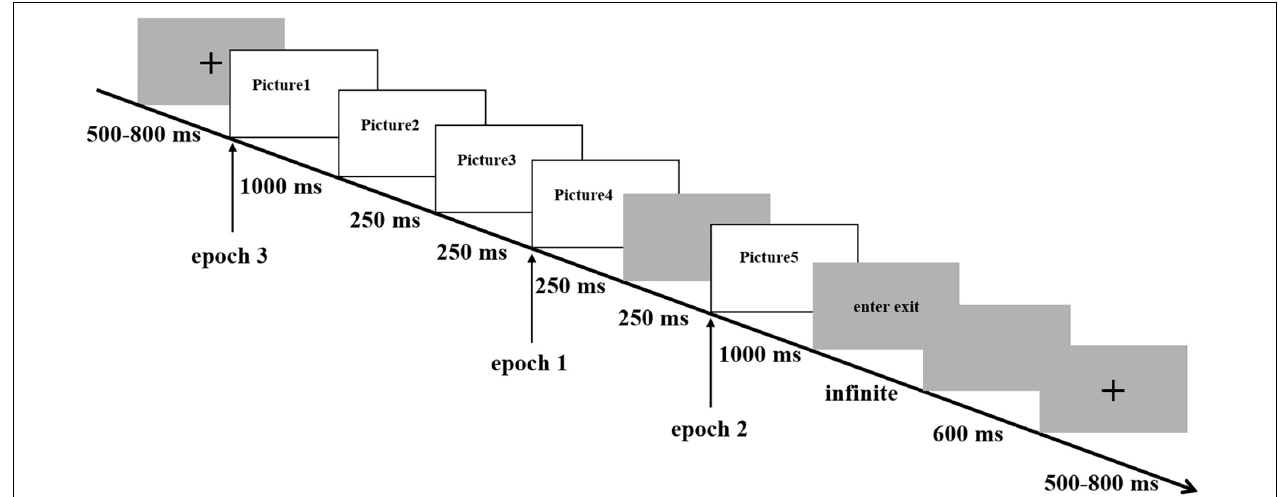
FIGURE 1 | Flow of experimental procedure and